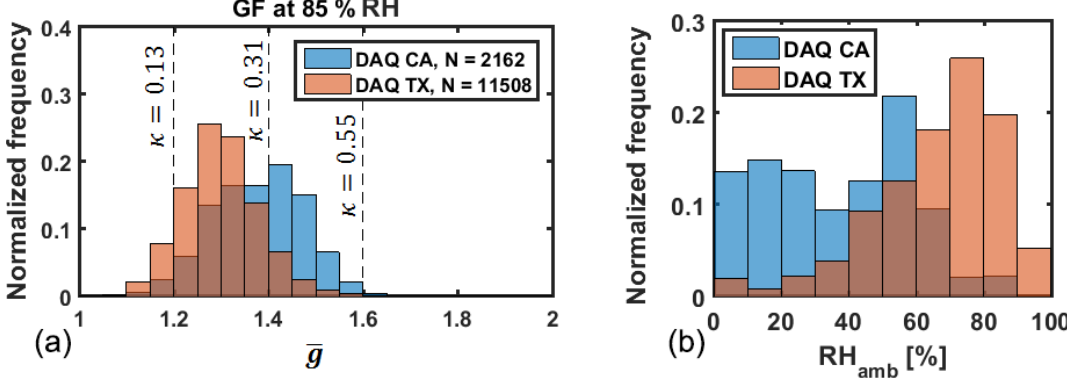
Figure 4. (a) Distribution of retrieved g values at RH = 85%. Median g values were 1.38 in California and 1.29 in Texas. (b) Relative humidity measurements during DAQ CA and TX.